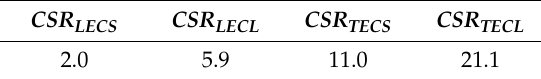
Table 1. Cavity to blade surface ratio of small leading edge cavitation ( CSR LECS ), of large leading edge cavitation ( CSR LECL ), of small trailing edge cavitation ( CSR TECS ) and of large trailing edge cavitation ( CSR TECL ).